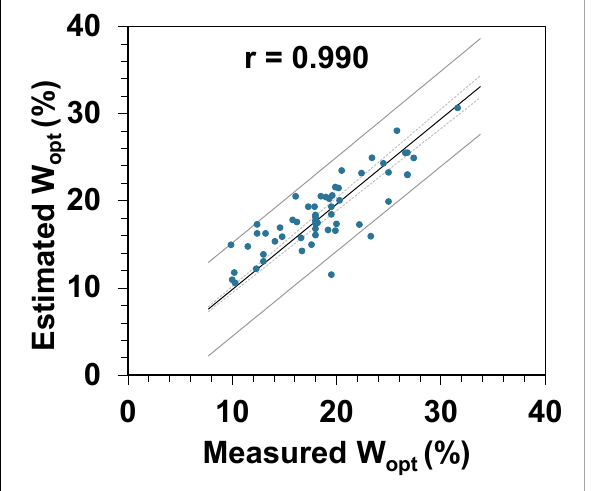
Figure 3. Correlation between measured and estimated w opt data from [19].